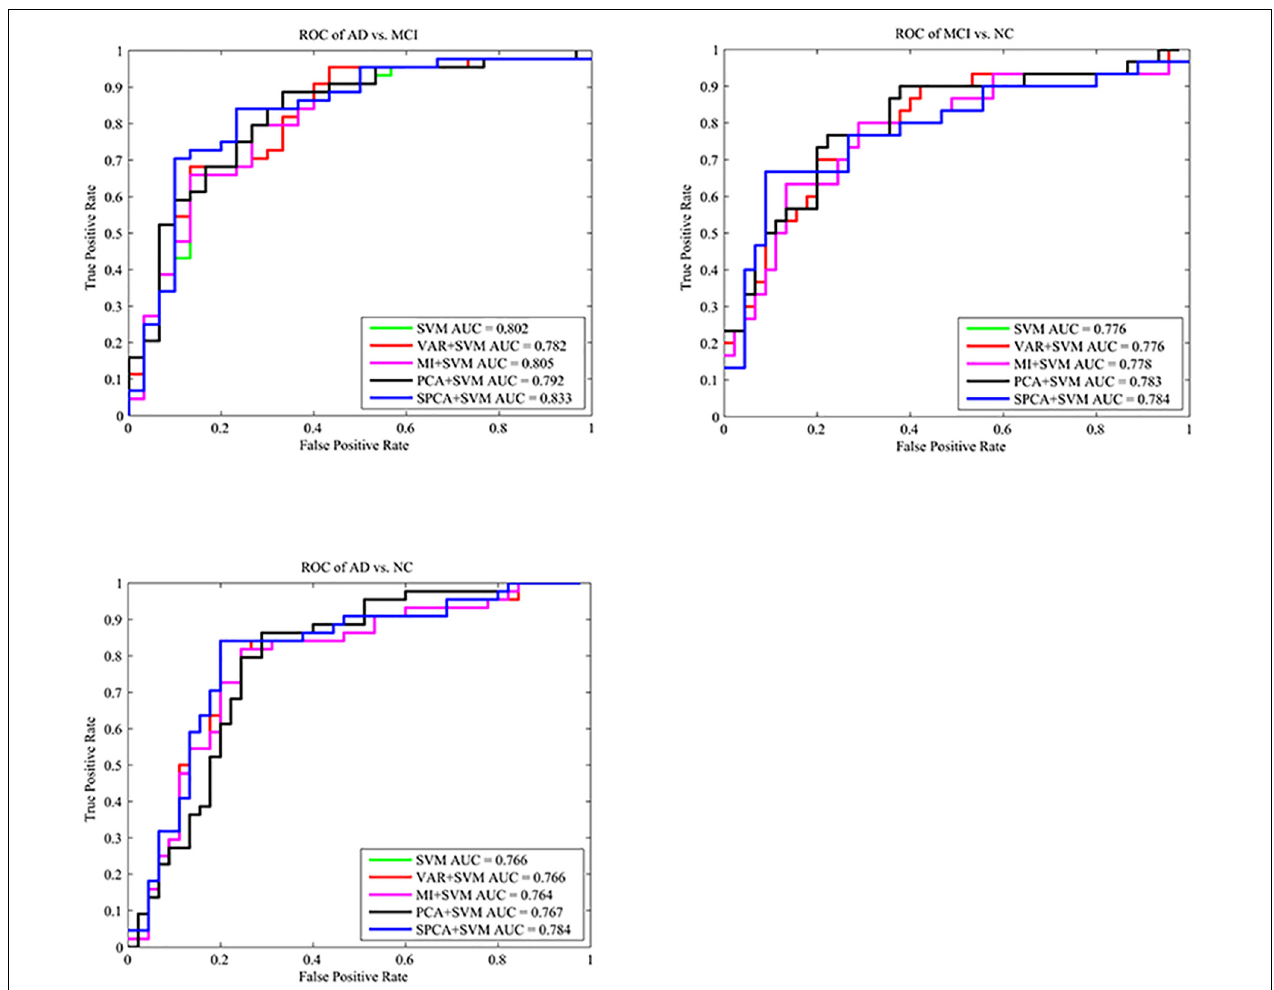
FIGURE 4 | Comparison of the ROC curves based on SVM, VAR+SVM, MI+SVM, PCA+SVM, and SPCA+SVM. ROC curves and AUC show that SPCA combined with SVM has the best performance for the three tasks.